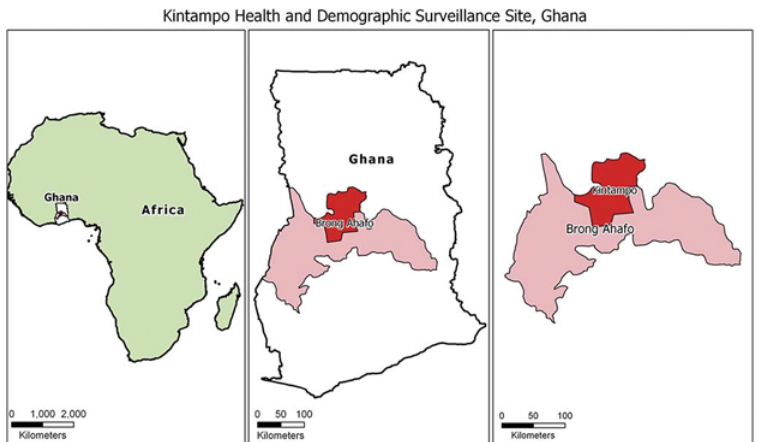
Fig 1. Map of the study